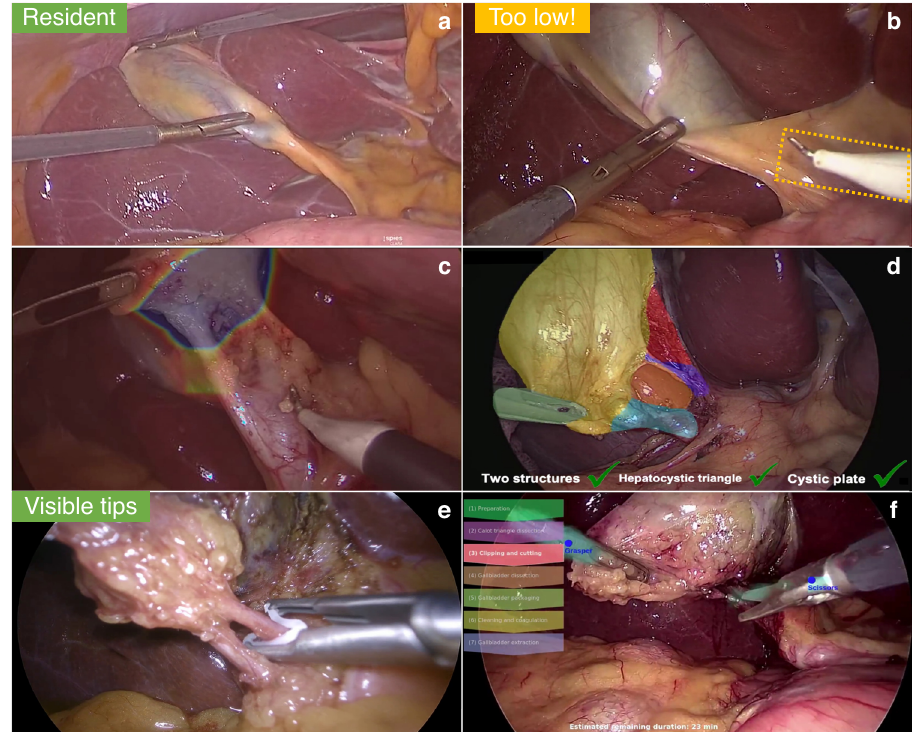
Fig. 2 CV-based real-time assistance in laparoscopic cholecystectomy. Overviewed CV models could be used to evaluate the dif fi culty of a case and whether it is fi t for a surgical resident ( a ), to warn surgeons against incising below the appropriate site ( b ), to guide safe dissection ( c ), to automatically evaluate safety measures ( d ), to prevent misapplications of clips ( e ) and to improve OR staff awareness and